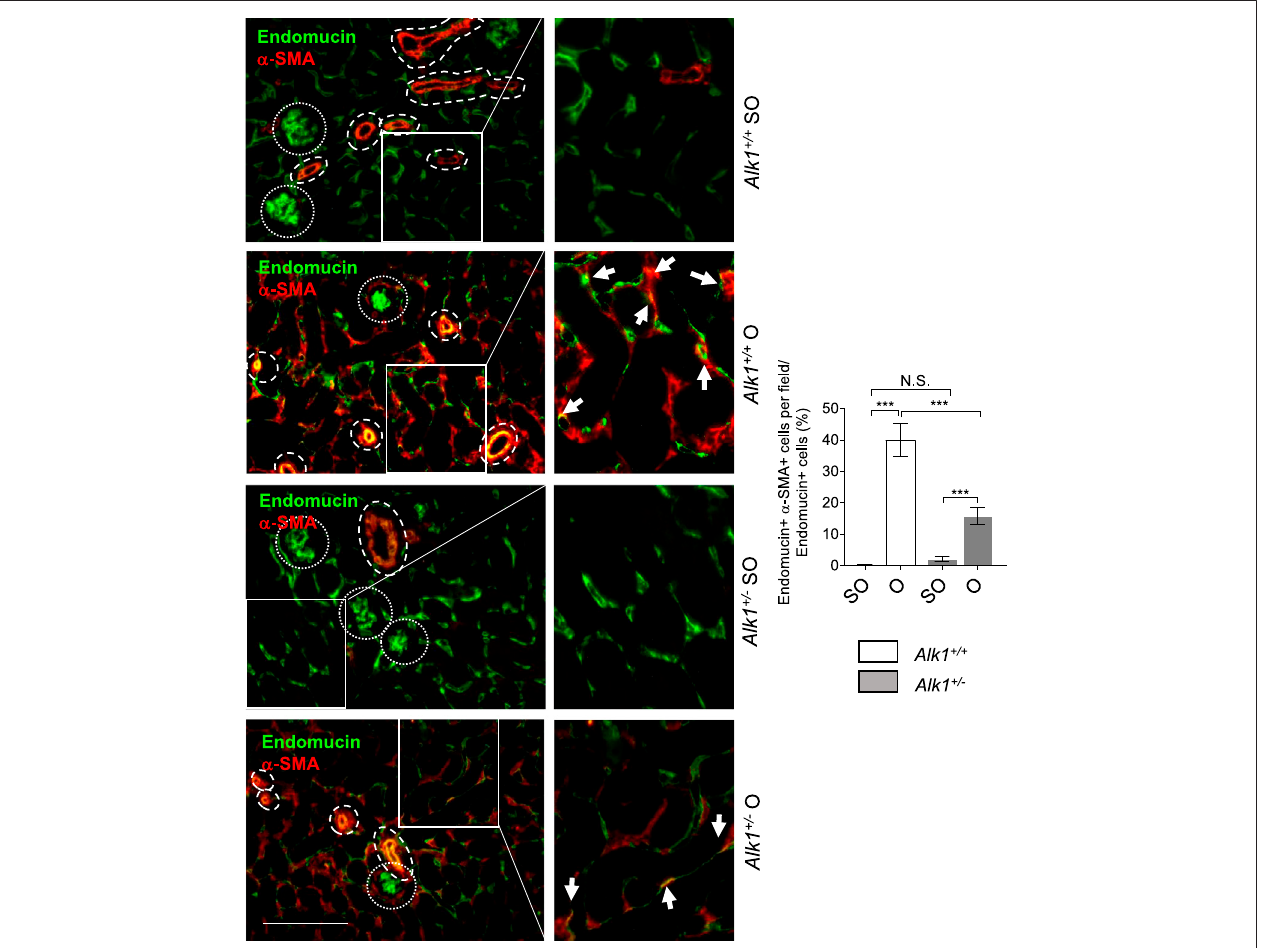
FIGURE7| Endothelial-to-myo fi broblasttransdifferentiationafterUUOin Alk1 +/+ and Alk1 +/ − mice.Doubleimmuno fl uorescenceofendomucin(endothelialmarker) and α -SMA(myo fi broblastmarker) inSOand Okidneys from Alk1 +/+ and Alk1 +/ − mice andquanti fi cationofdoubleendomucinand α -SMApositivecells. Cropped areas withsmall dashed lineareglomeruli, notconsidered for theanalysis.Cropped areas with large dashed linesaresmall vessels,also not considered forthe analysis. *** p < 0.001; N.S. Not statistically signi fi cant (Two-way ANOVA). Arrows identify double endomucin+ — α -SMA+ cells. Scale bar = 200 microns.